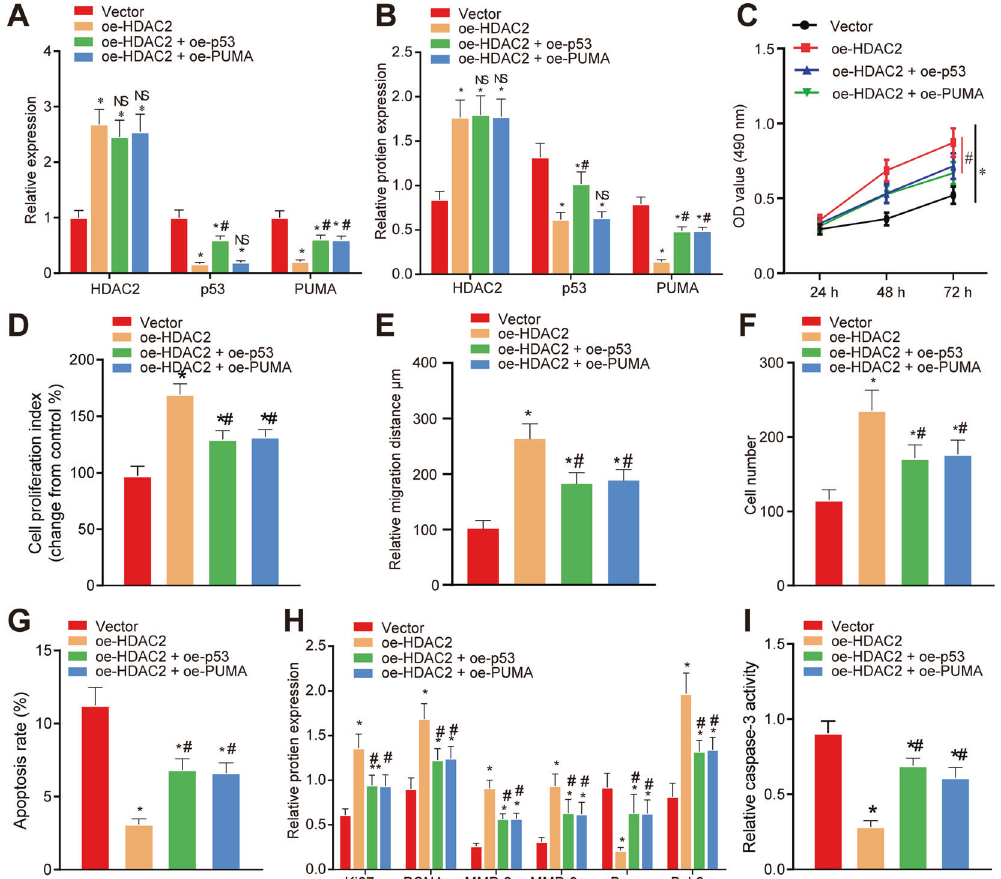
of HDAC2, p53, and PUMA48 hours after transfection. C HTR8/SVneo cell viability at 24 th , 48 th , and 72 nd hour after transfection evaluated by MTT assay. D HTR8/SVneo cell proliferation 48 h after transfection evaluated by BrdU assay. E Migrating ability of HTR8/SVneo cells 24 h after transfection examined using scratch assay. F HTR8/SVneo cell invasion 24 h after transfection assessed using transwell assay. G HTR8/SVneo cell apoptosis in each group 48 h after transfection analyzed by fl ow cytometry. H Protein expression of Ki67, PCNA, MMP-2, MMP-9, Bax, and Bcl-2 in HTR8/SVneo cells 48 h after transfection studied by western blot. I Caspase-3 activity in HTR8/SVneo cells 48 h after transfection. * p < 0.05 vs. vector; # p < 0.05 vs. oe-HDAC2. The quantitative data were presented as mean ± standard deviation. Difference between